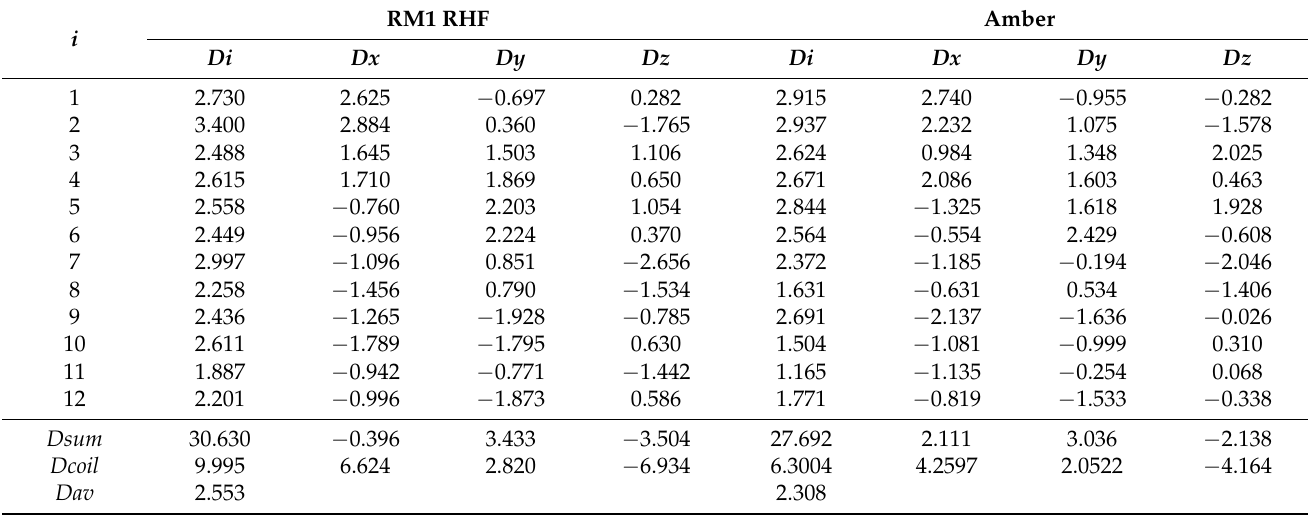
Table 4. Values of dipole moments for a coil of the helix-like L-F PNT computed using RM1 (RHF) and Amber (after RM1) methods. All values of dipole moments are given in Debye